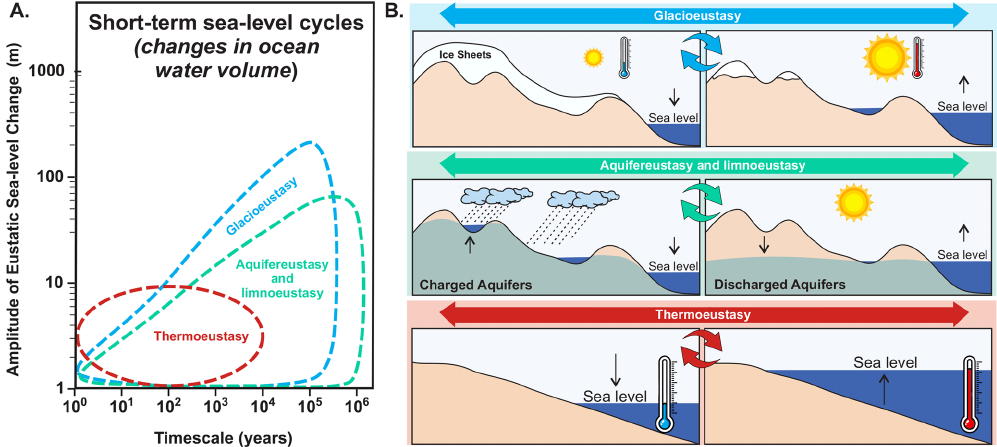
Figure 4. (a) Log-scale diagram of the timing and amplitudes of the main mechanisms that control “short-term” sea-level variations. The values represented must be considered averages (modified from Sames et al., 2016); (b) schematic diagrams representing the processes that promote changes in sea level (glacioeustasy, aquifer eustasy + limnoeustasy, and thermoeustasy) during climate changes induced by orbital